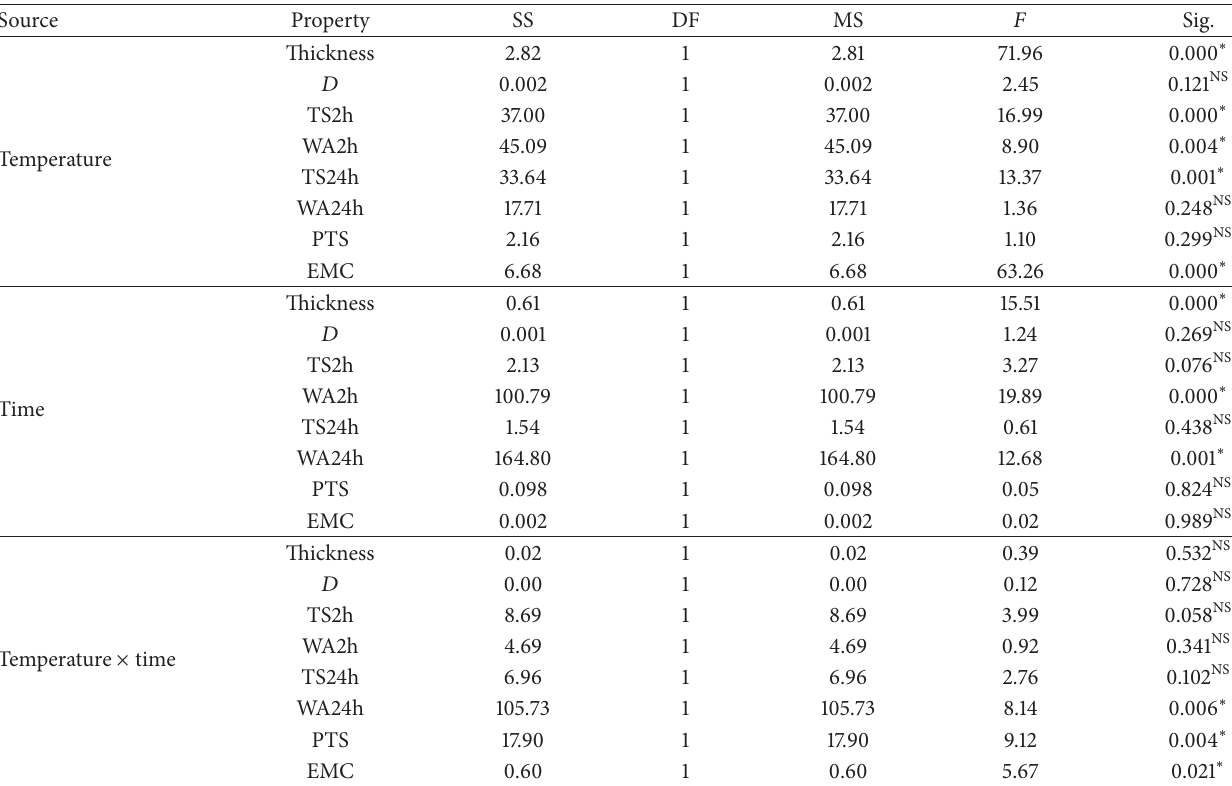
Table 3: Factor analysis of plywood physical